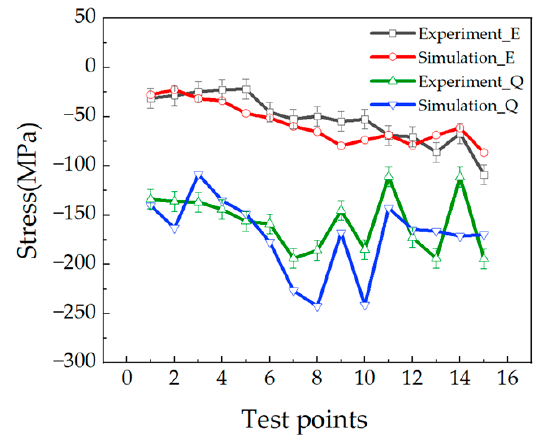
Figure 14. Comparison of the experimental data and the simulated results. Experiment_E is the measured stress after cold expansion; Simulation_E is the simulated stress after cold expansion; Experiment_Q is the measured stress before cold expansion; and Simulation_Q is the simulated stress before cold